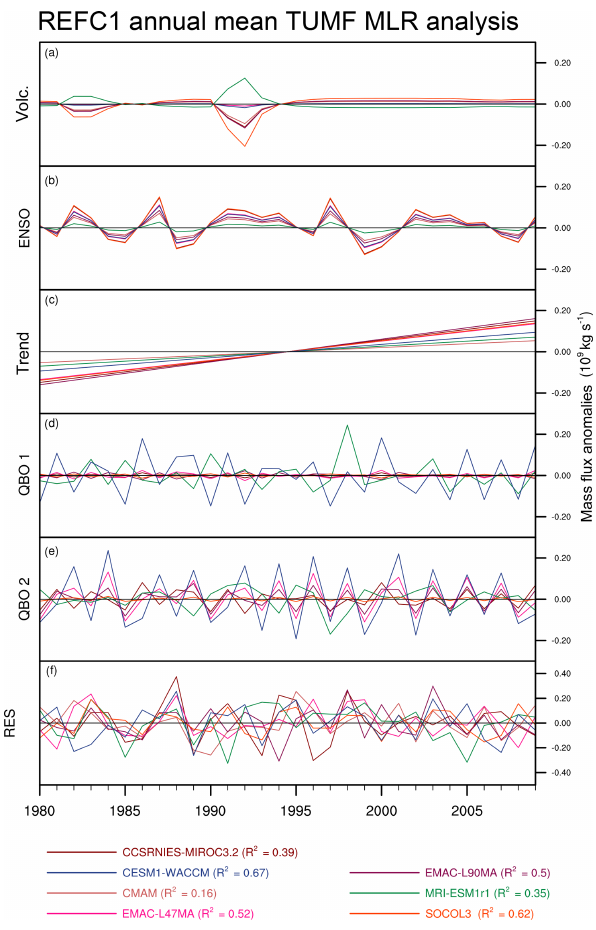
Figure 11. Time series for REF-C1SD simulations of the compo- nents of the annual mean tropical upward mass flux ( × 10 9 kgs − 1 ) attributed to (a) volcanic aerosol, (b) ENSO, (c) linear trend, (d, e) QBO, and (f) regression